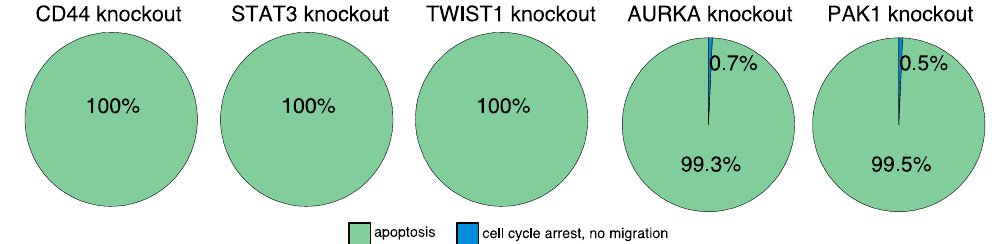
Figure 5. In-silico screening for therapeutic targets. Automated model perturbation screening identified a list of proteins that might induce apoptosis. Displayed is the long-term behavior of the model after introducing the model-suggested interventions. An in-silico knockout of CD44, STAT3, or TWIST1 induce apoptosis. Similar results were obtained for AURKA or PAK1 knockouts. These knockouts mainly induce apoptosis and to a minority cell cycle arrest combined with inhibited migration trades.